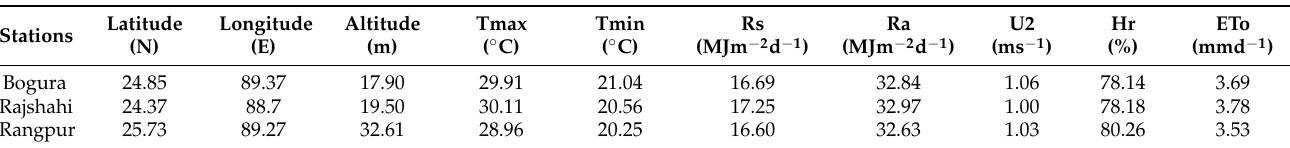
Table 1. The geographical sites and daily mean values of three selected in situ observational datasets in northwest